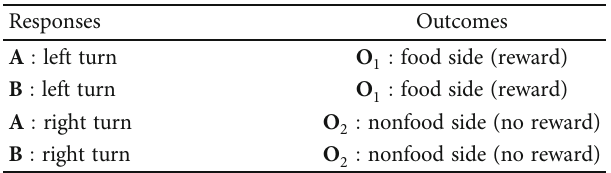
Table 1: Alternative de fi nitions of experimental events in a T-maze experiment depending on the placement of the food and chosen